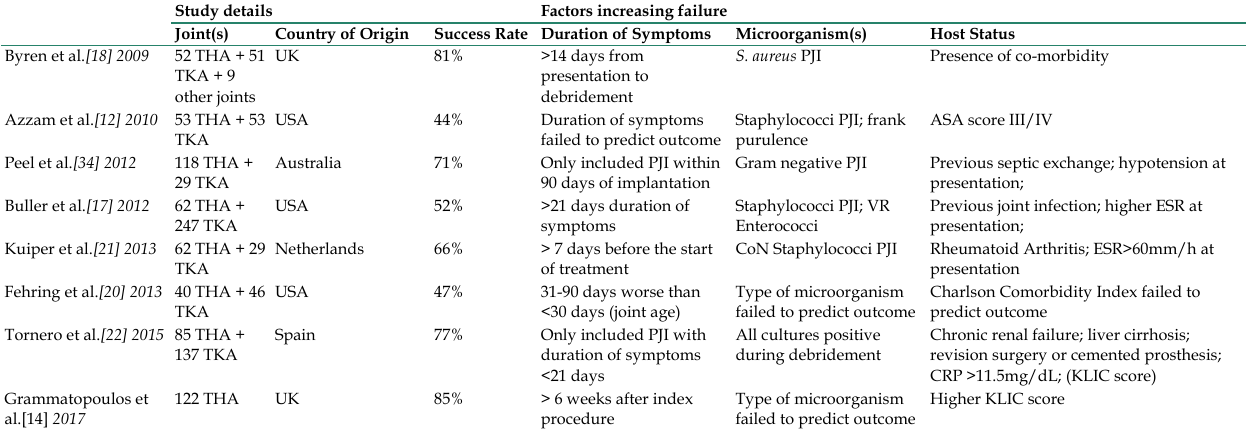
Table 1. Summary of selected findings that increase risk of failure after DAIR Study